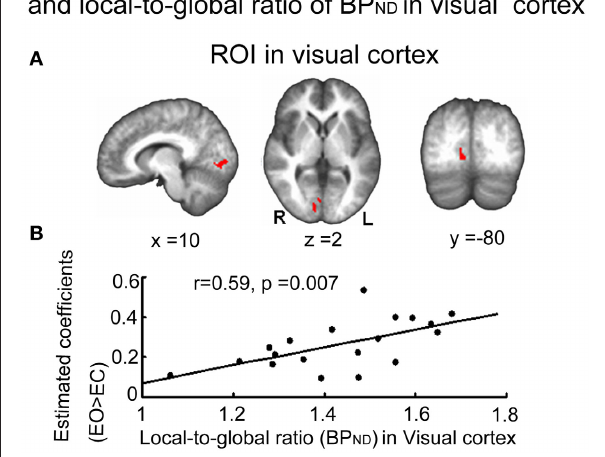
FIGURE 3 | Correlation between estimated coefficients (EO > EC) and the local-to-global ratio of GABA A receptor BP ND in the visual cortex. (A) Activated regions in the visual cortex during eyes open (EO) when compared to eyes closed (EC) taken as ROIs. (B) Positive correlation between the estimated coefficients for the contrast [EO > EC] and the local-to-global ratio of GABA A receptor BP ND in the visual cortex [ r = 0 . 59, p = 0 . 007 uncorrected ( p < 0 . 05, with Bonferroni correction)] ( n = 19).